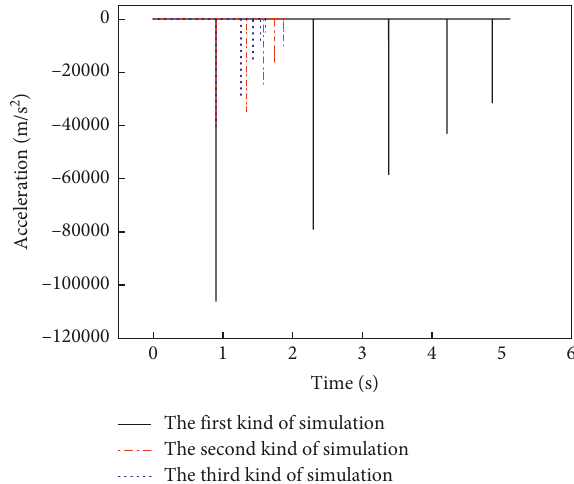
Figure 10: Position of the centroid mass.